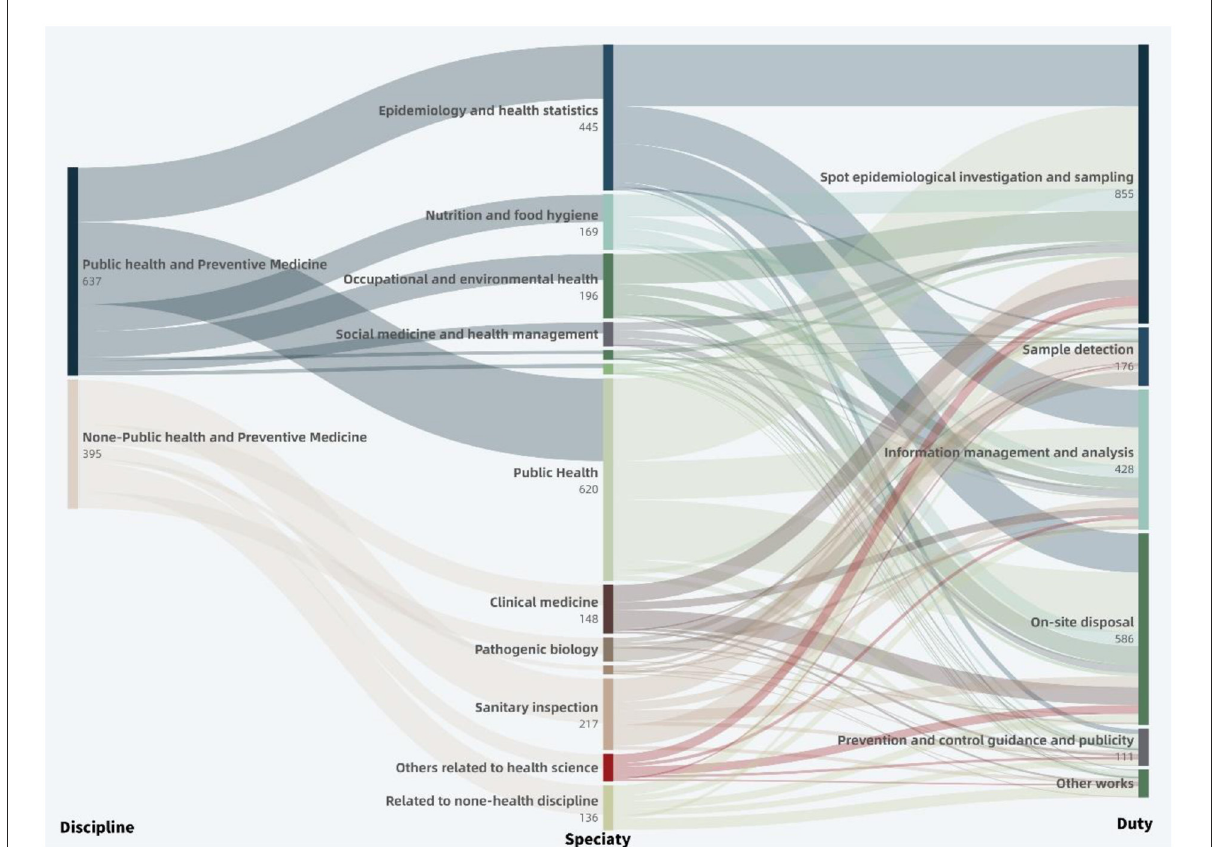
FIGURE1 Distribution of discipline and duty during COVID-19 pandemic of frontline staff within Beijing Disease Prevention and Control System. Discipline → Specialty shows the specific majors distribution of public health and non-public health disciplines (one person can have multiple special majors); Specialty → Duty shows the distribution of these specific majors act on different epidemic prevention and control